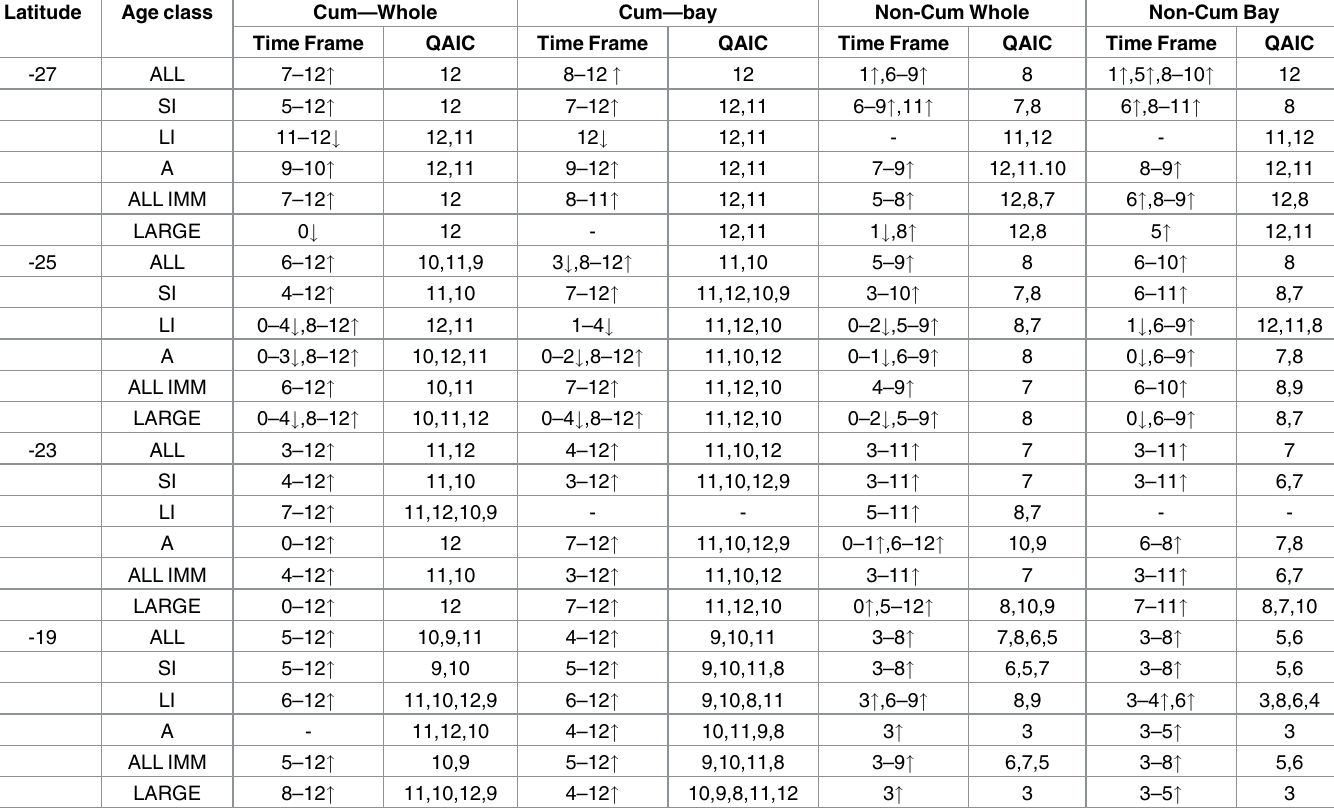
Table 3. Model results for green turtles and cumulative mean discharge. " denotesincreasedstrandings rates with increaseddischarge. # denotes decreased strandingrates with increaseddischarge. Age class abbreviations: ALL = all turtles, SI = small immature, LI = large immatures, A = adult-sized, ALL IMM = all immature sized animals(small + large), Large = all large turtles (large immatures + adult-sized). The time frame is reportedin monthly ranges where responseswere noted. The values reportedin qAIC are the months with the most significantqAIC